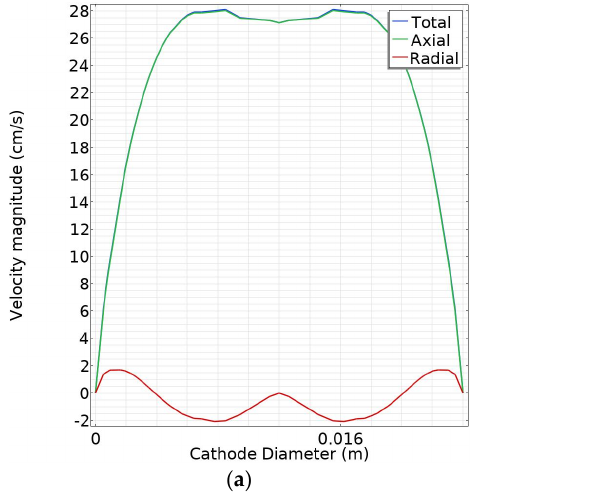
Figure 6. Optimal fluid velocity distribution (cm/s): ( a ) thruster with argon as propellant gas; ( b ) thruster with xenon as propellant gas. Notice the different scales necessary to reinforce the contrast in both pictures.